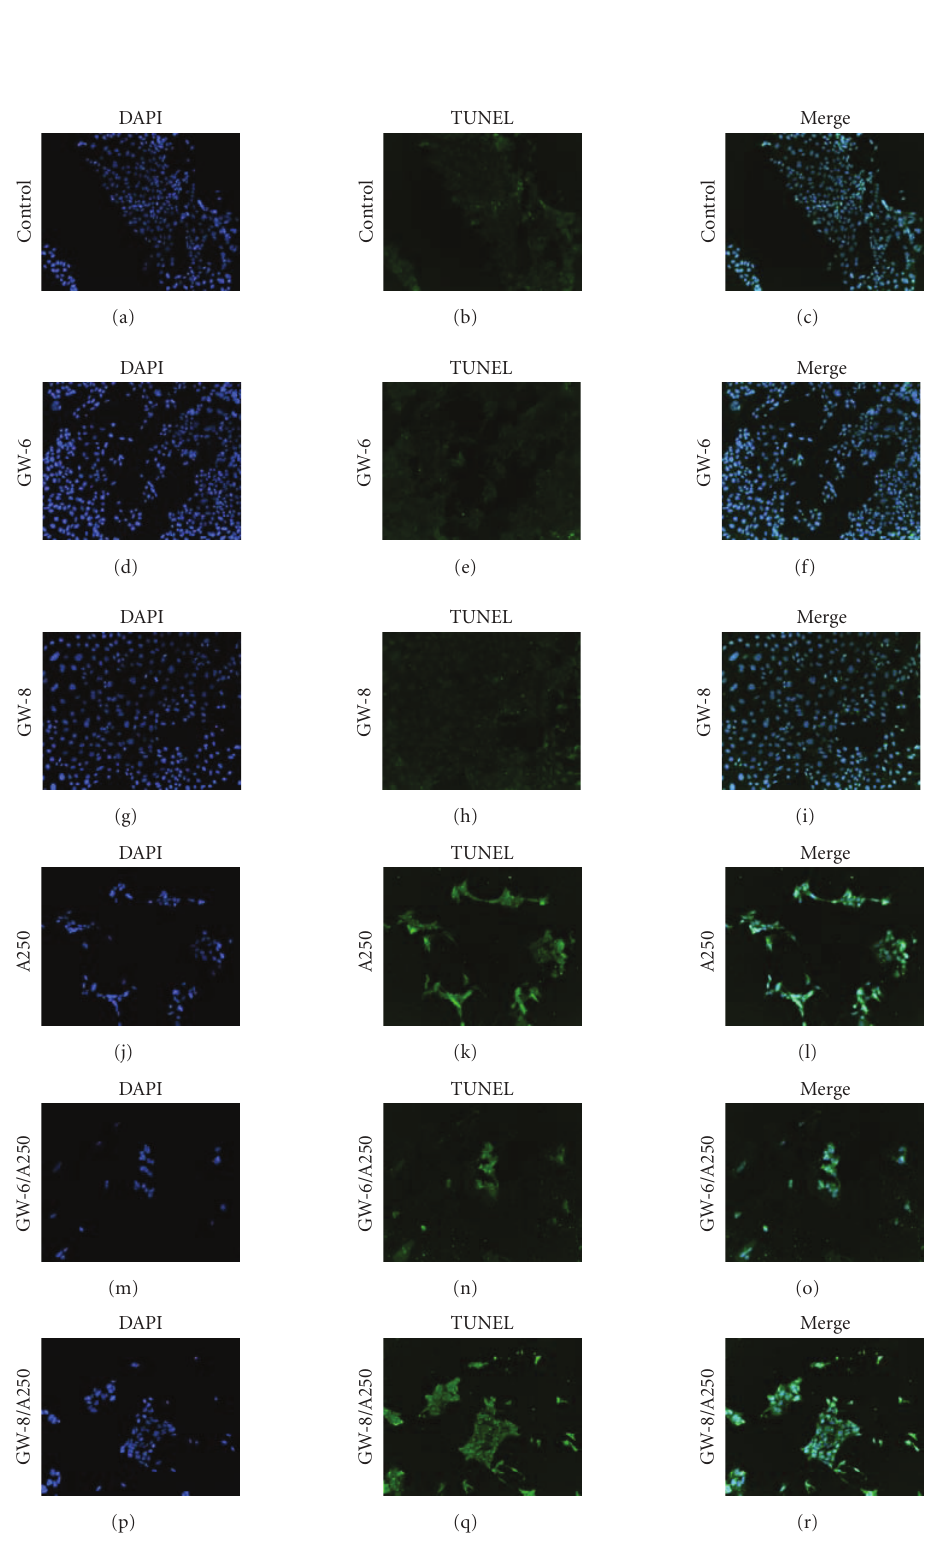
Figure 11: GW501516 pretreatment has no e ff ect on anisomycin-induced apoptosis. Serum-starved cells were stimulated with (a)–(c) serum-free media (control), (d)–(f) 10 − 6 M GW501516 (GW-6), (g)–(i) 10 − 8 M GW501516 (GW-8), (j)–(l) 250ng/mL anisomycin (A250) for 24 hours, (m)–(o) 10 − 6 M, or (p)–(r) 10 − 8 M GW501516 for 3 hours pretreatment followed by 10 − 6 M or 10 − 8 M GW501516 for 24 hours with A250 (GW-6/A250 and GW-8/A250). The cells were incubated with terminal transferase and biotin-16-dUTP for one hour, followed by two 45-minute incubations with streptavidin-Cy2 and anti-DAPI. The cells were then mounted on slides, visualized with a fluorescent microscope, and captured with a camera. Apoptotic cells are shown in green, while the blue represents DAPI-positive